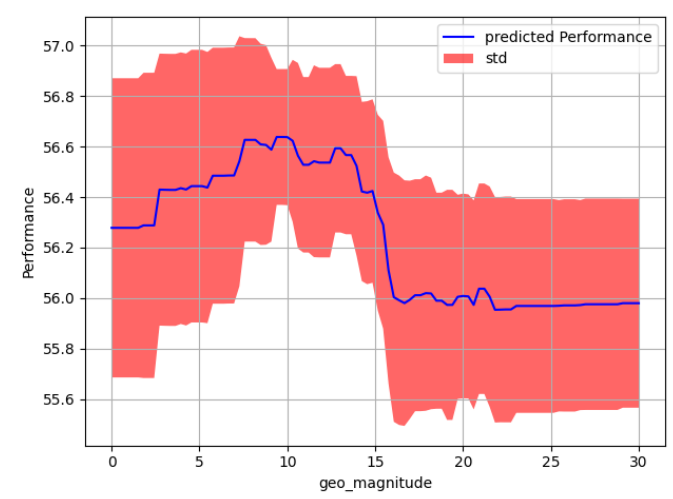
Figure 9. Results from SmartAugment on the KITTI dataset indicate that the geometric magnitude, which is the most important hyperparameter for this particular dataset, should be low. Taking this into account gives a possible explanation for why weighting the data augmentation with weights that focus on geometric augmentations might hurt performance (mean IoU) for the KITTI dataset.